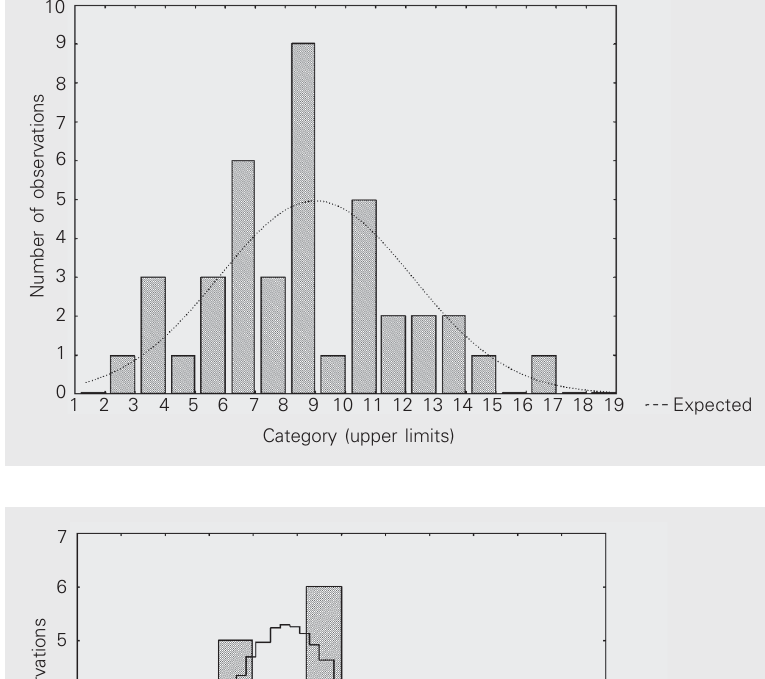
Figure 3. Distribution of radiosensitivity among indi- viduals aged on average 23.6 years (Kolmogorov- Smirnof test, d = 0.68, nonsignificant).